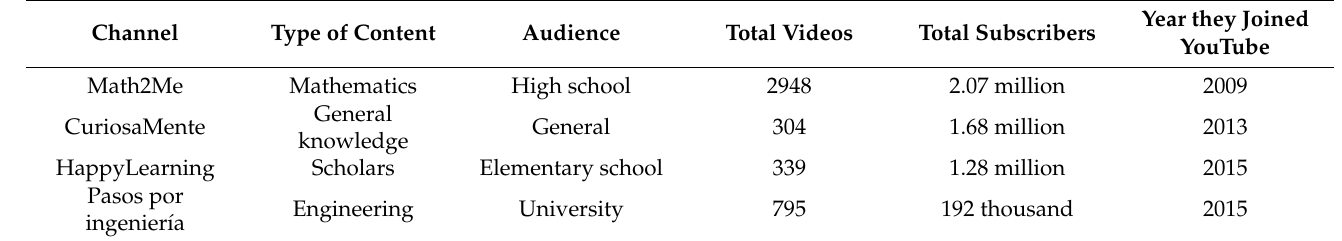
Table 1. Characteristics of the